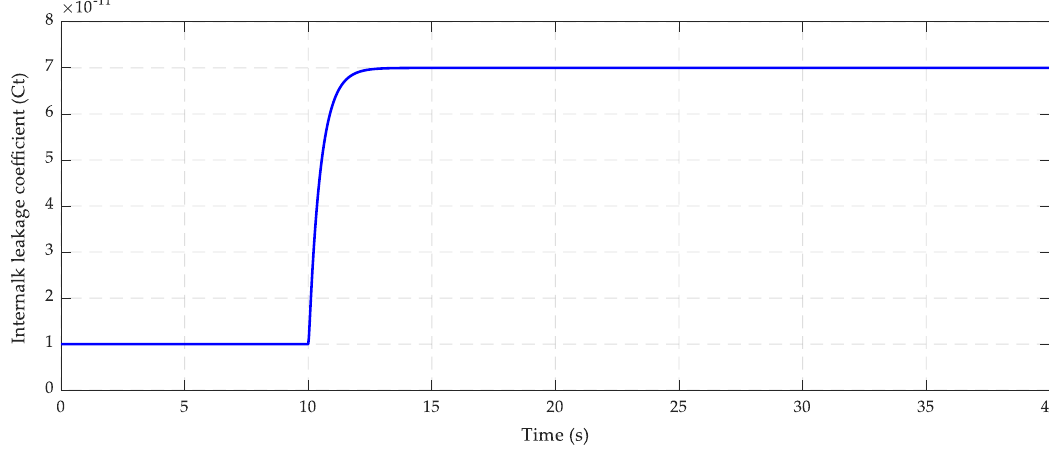
Figure 3. Internal leakage coefficient.